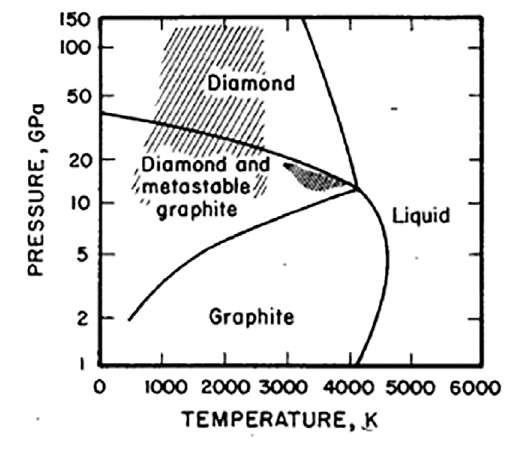
Figure 5. Pressure-temperature phase diagram of carbon (adapted from Meyers 28 ).